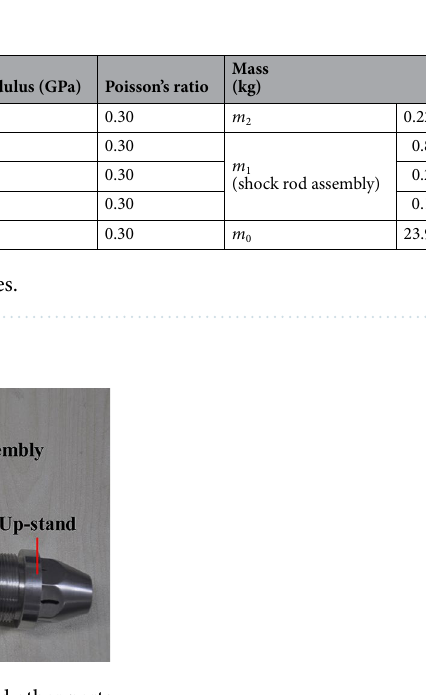
Figure 2. Configuration of the suspension spring and other parts.